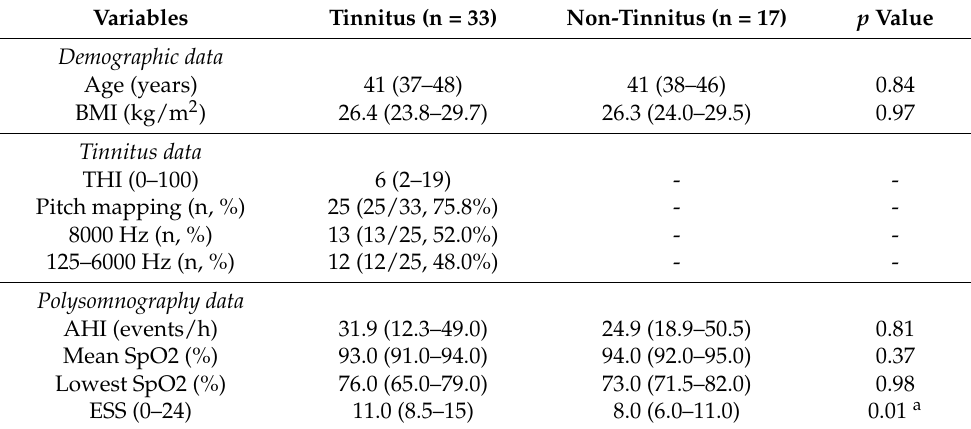
Table 1. Comparisons in demographic data, tinnitus data and polysomnographic data between tin- nitus and non-tinnitus groups.